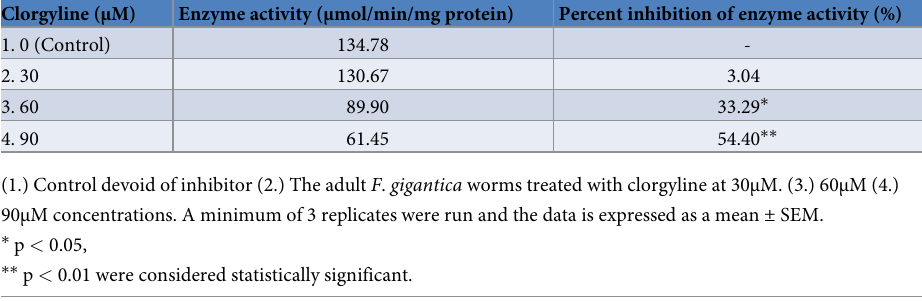
Table 1. The specific enzyme activity and percent inhibition of mitochondrial MAO-A enzyme in F . gigantica worms following treatment with different doses of clorgyline. Clorgyline ( μ M) Enzyme activity ( μ mol/min/mg protein)